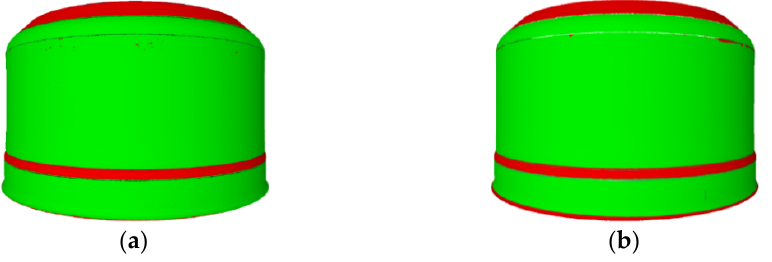
Figure 12. Areas of components after technological tests within given tolerances: V (cid:2869) ( a ); V (cid:2870) ( b ). Values of indicators obtained in trials V 1 and V 2 were compared with regression models obtained in the optimisation process. The best compliance for the individual indicators was achieved for the second and third zones, which may result from